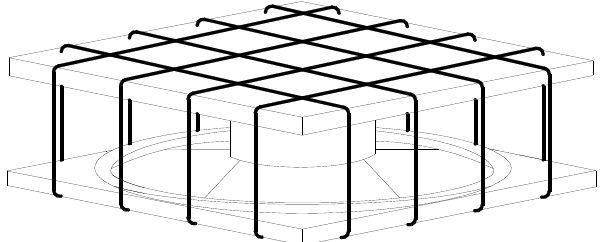
Figure 2. SMA negative stiffness hyperboloid shock absorber.